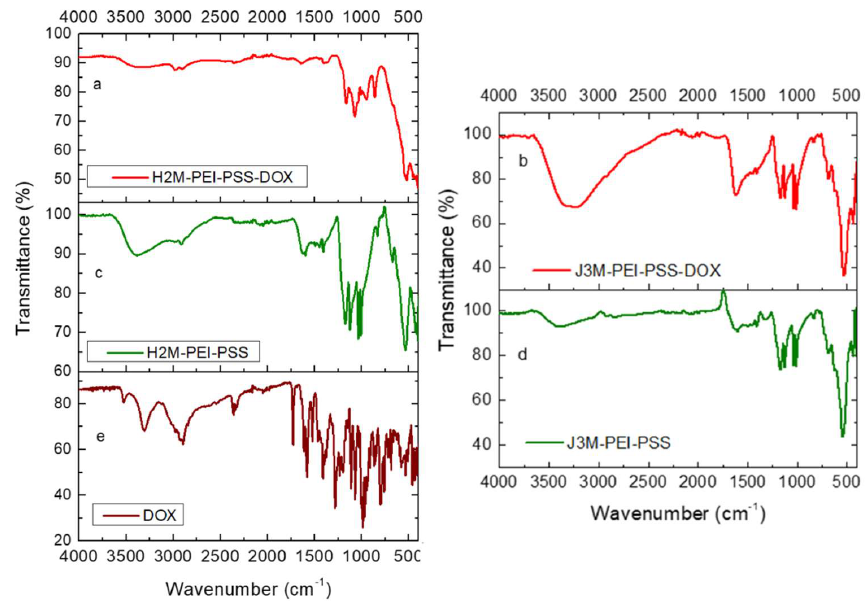
Figure 5. FTIR spectra of the DOX-loaded ( a , b ) and polyelectrolyte coated ( c , d ) magnetic MNRs and of pure DOX ( e ).